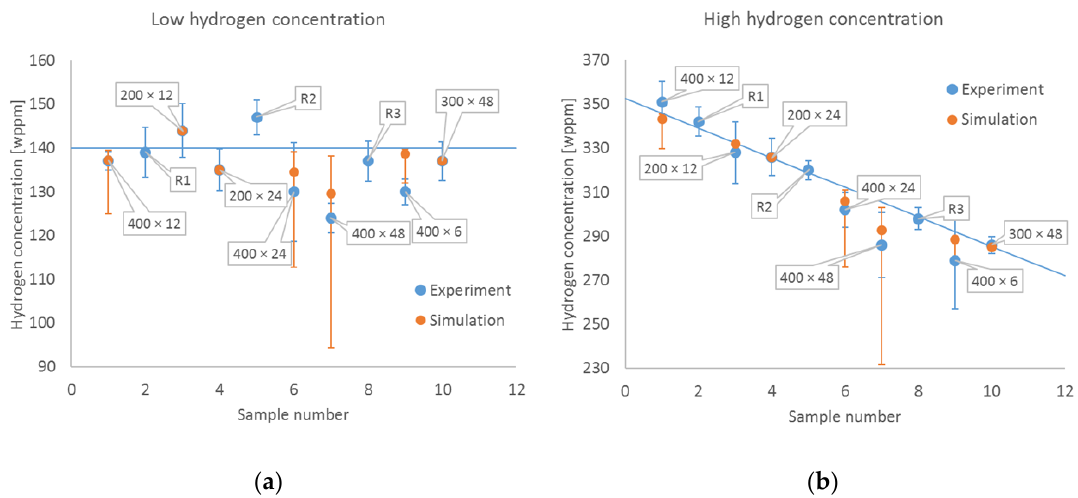
Figure 4. Simulation results (in orange) compared with experimental measurements (in blue) of the samples subjected to low ( a ) and high ( b ) hydrogen enrichment.